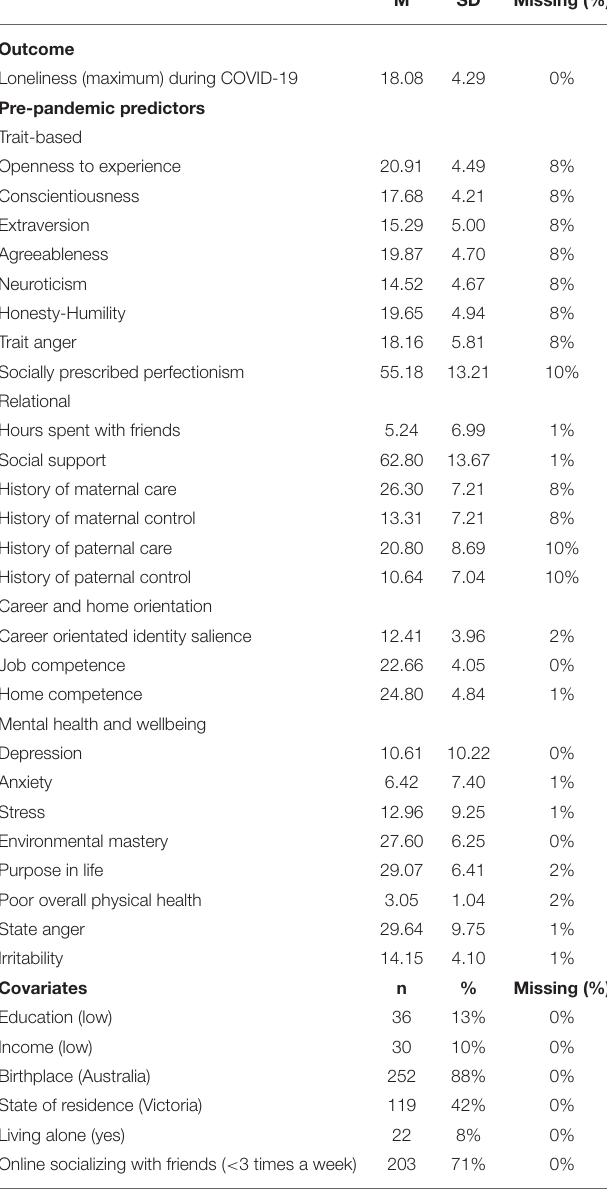
negatively associated with pandemic loneliness ( β range = − M SD Missing (%)